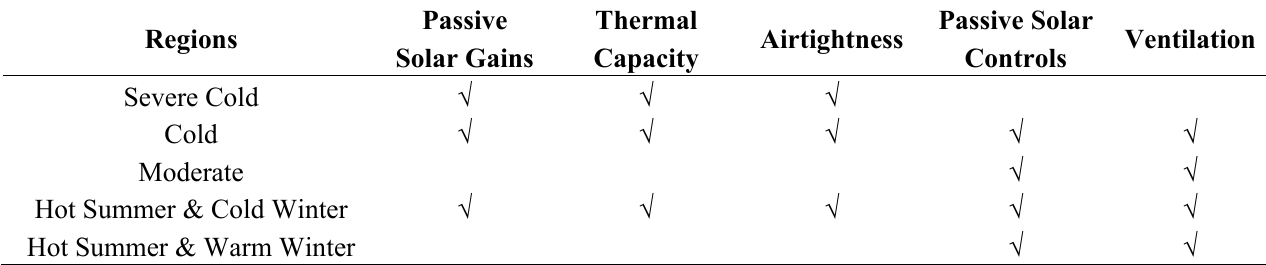
Table 6. Climate-Responsive Dwelling Design Strategies for Five Chinese Regions.